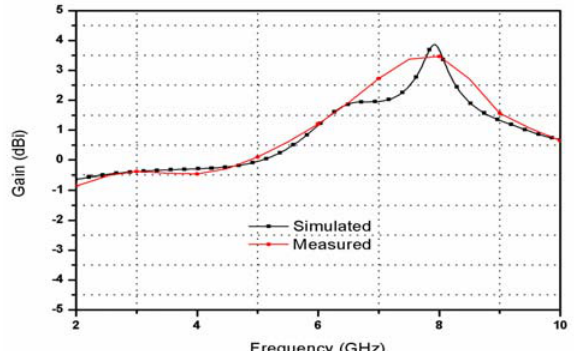
Figure 11: Simulated and measured gain against frequency for the octagonal ring shape wideband antenna. Table 2: Comparison between the proposed antenna and some other existing wideband antennas